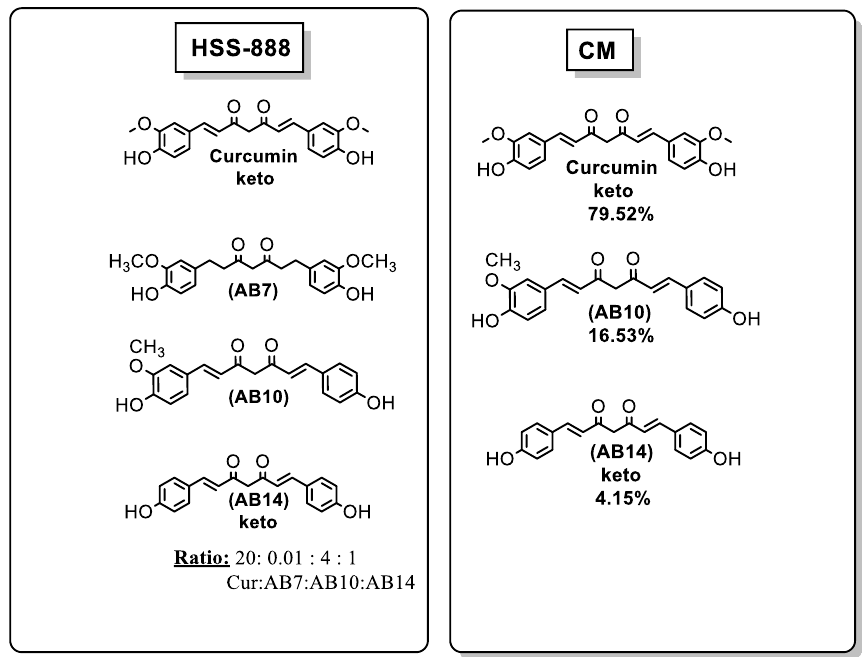
Figure 5. curcuminoids having anti-amyloid properties. Figure 5. Mixed curcuminoids having anti-amyloid